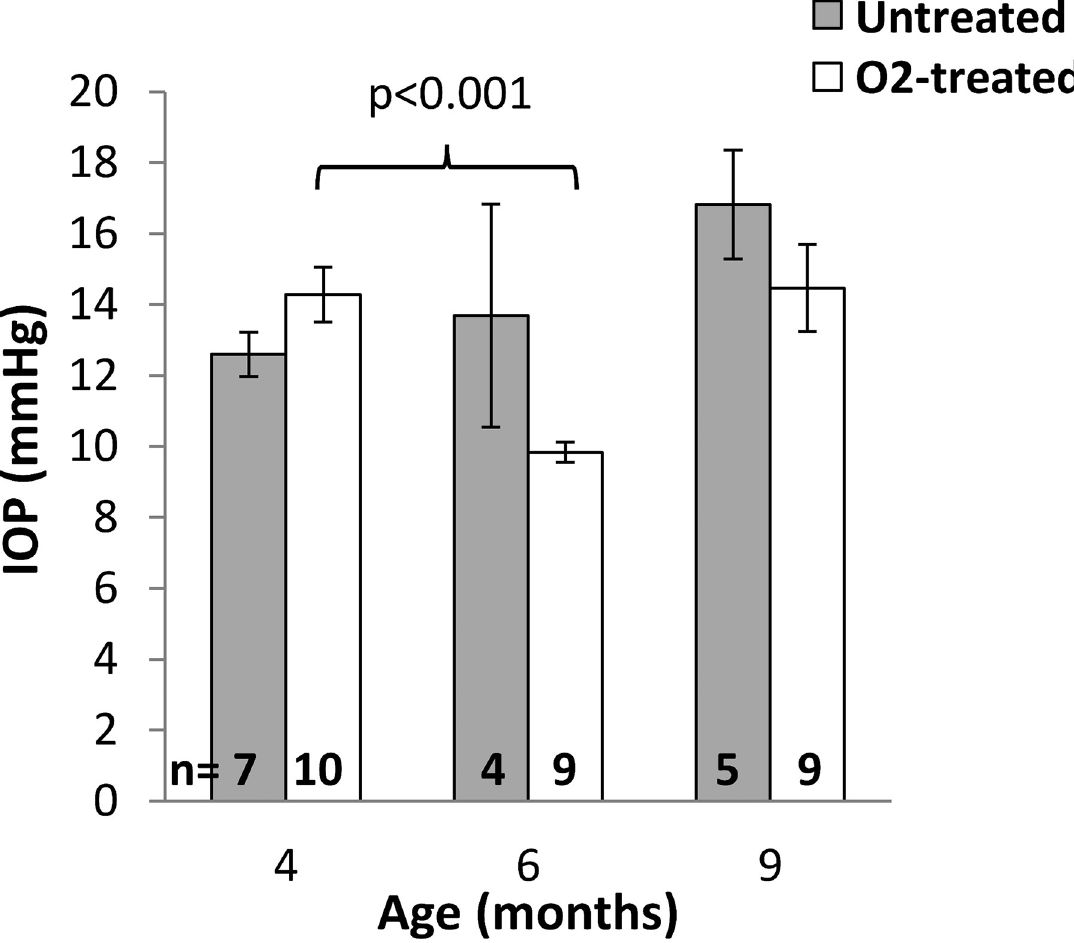
Fig 1. Intraocular pressure from DBA/2J mice. Mice were housed under room air (untreated) or 30% oxygen (O 2 -treated) beginning at 4.5 months of age. IOP was measured at 4, 6, and 9 months of age. Group means ± SEM are plotted after averaging the IOP of both eyes. The numbers of animals for each group are shown. Significant differences from post-hoc tests are indicated.